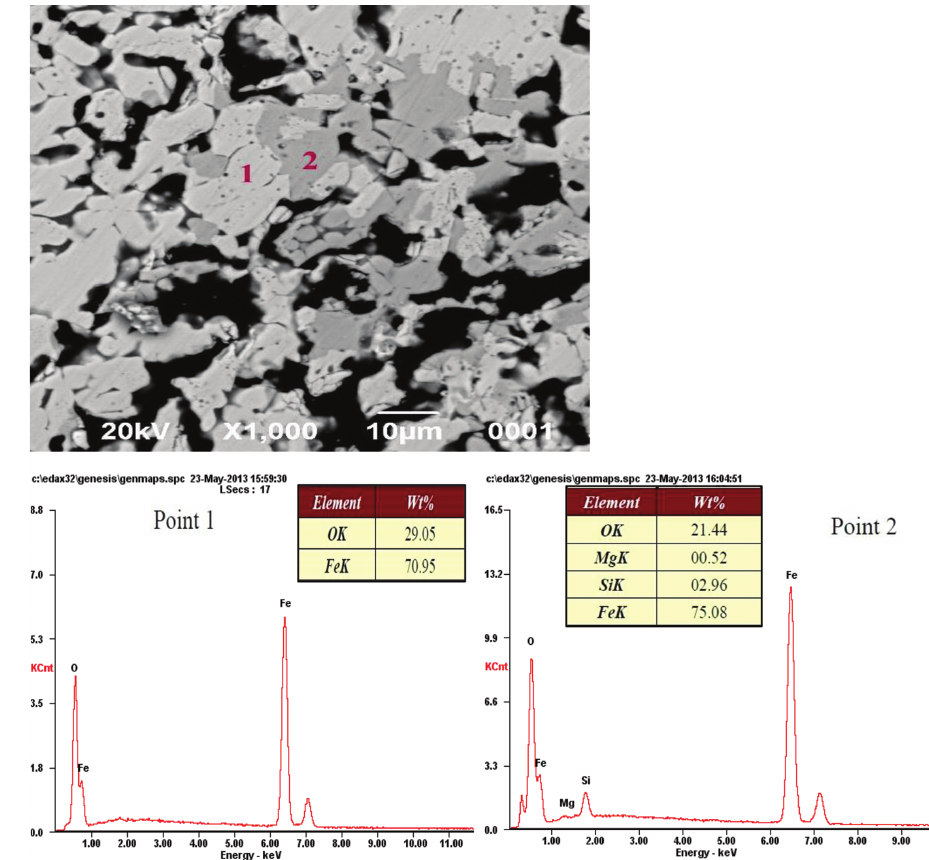
Figure 6: SEM-EDS results of fired pellets containing 2.0% coke (Preheating at 1,050°C for 15 min and firing at 1,250°C for 15